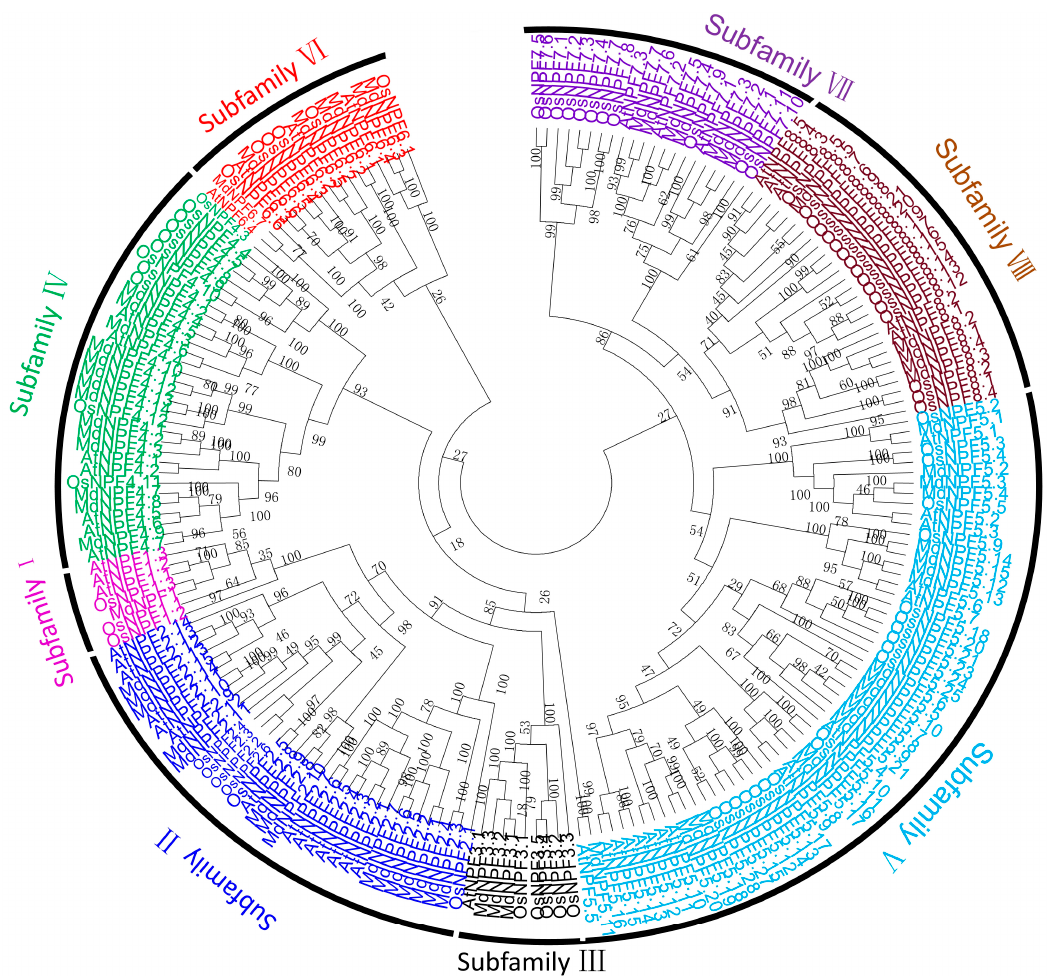
Figure 1. Phylogenetic tree and subfamily information for MdNPFs, AtNPFs, and OsNPFs. Neighbor-Joining method was used in tree construction with MEGA 5 software for 205 full-length amino acid sequences from apple, Arabidopsis , and rice. Eight subfamilies are indicated with Roman numerals. The numbers at nodes of the phylogenetic tree indicate the bootstrap values expressing branching probability per 1000 replicates; the bootstrap values of the confidence levels are shown as percentages.